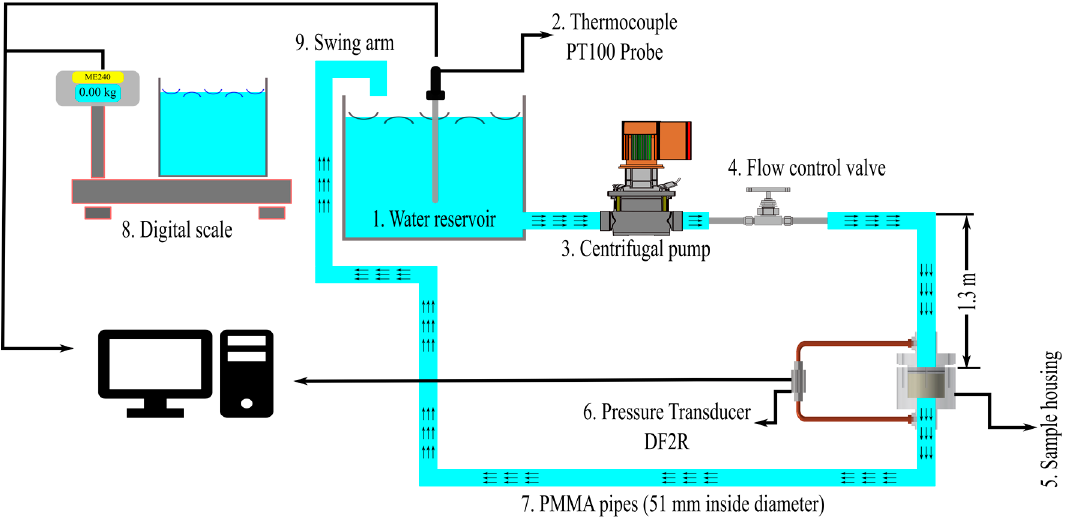
Figure 7. Schematic drawing of the experimental pressure drop